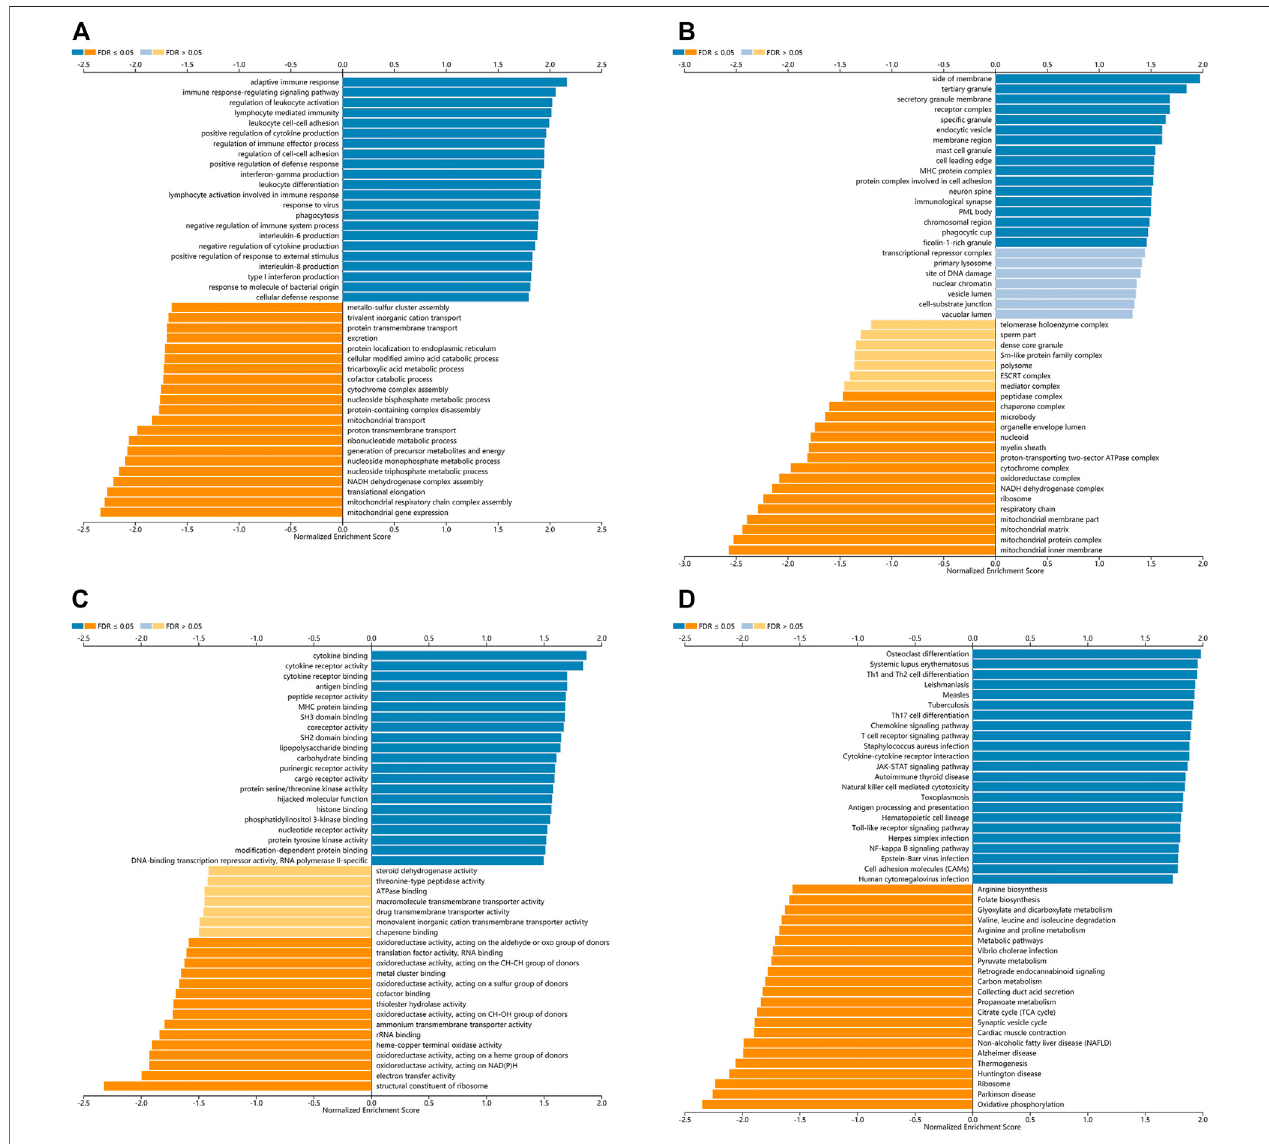
FIGURE 8| The GO and KEGG pathway analyses ofTLRs in KIRC. (A) Biological processes involved in TLRs in KIRC. (B) Cellular components involved in TLRs in KIRC. (C) Molecular functions involved in TLRs in KIRC. (D) KEGG pathways involved in TLRs in KIRC.